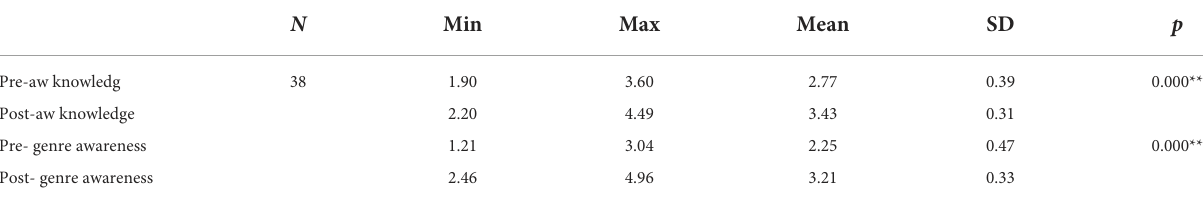
TABLE 3 Differences of EFL learners’ pre- and post- academic writing knowledge and genre